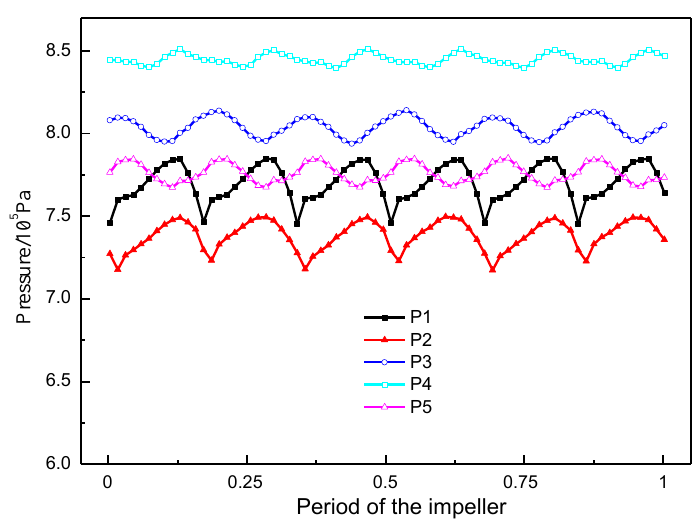
ff erent monitoring points under Q